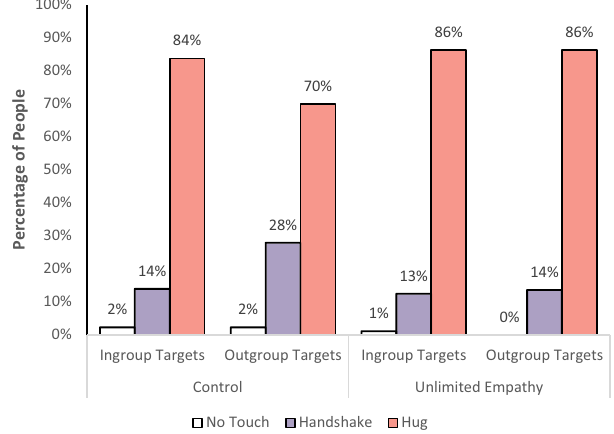
Fig. 9 | Empathic behavior (no interpersonal touch; handshake; hug) toward ingroup and outgroup targets, as a function of condition (i.e., unlimited empathy, n =88; and control, n =86). A signi fi cant difference in selecting the most empathic behavior (i.e., a hug) toward ingroup and outgroup members amongparticipantsinthecontrolcondition( p <0.001).Nosigni fi cantdifferencein selecting the most empathic behavior toward ingroup and outgroup members among participants in the unlimited condition ( p =1; McNemar ’ s chi-square test). All tests are two-tailed. Source data are provided as a Source Data fi